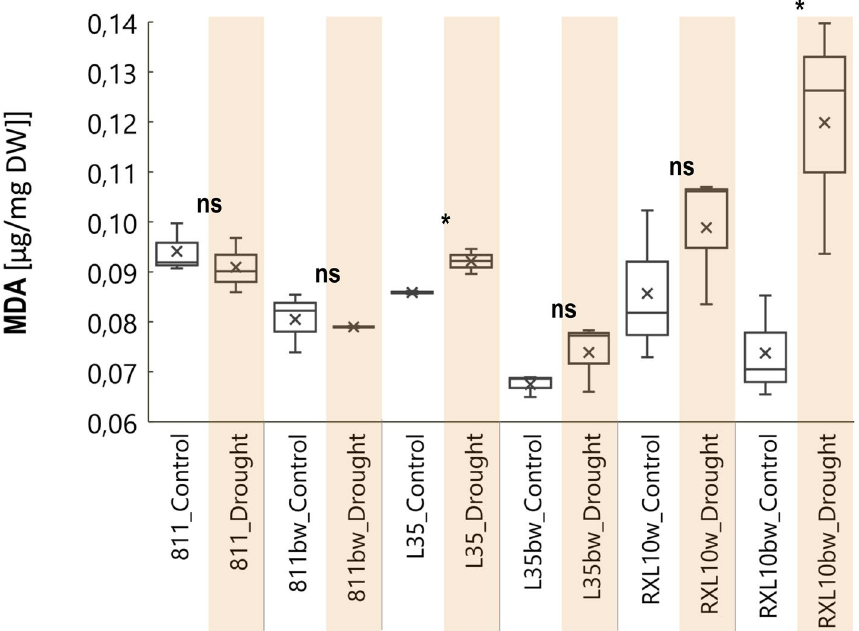
Figure 6. Box plot of malondialdehyde content (MDA) by glaucous (811, L35, RXL10) and non-glaucous (811bw, L35bw, RXL10bw) near-isogenic lines of rye and by soil water status (control or drought). The statistically significant differences between the means in control and drought were verified for P ≤ 0.001(***), P ≤ 0.01(**), P ≤ 0.05(*) according to Student’s test. Ns not